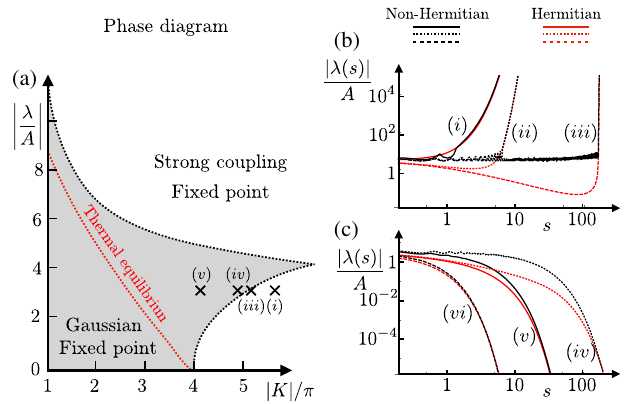
FIG. 2. (a) Phase diagram of the non-Hermitian sine-Gordon field theory, obtained from numerical integration of the flow equations (52) and (53). In the gray region the theory flows toward the Gaussian fixed point located at the origin. The phase boundary is signaled by the black dotted line. For comparison we also show the transition line for the Hermitian (thermal equilibrium) theory. Panels (b) and (c) display the renormaliza- tion group flow toward the strong coupling fixed point (b) and the Gaussian fixed point (c) for the non-Hermitian sine-Gordon theory and the corresponding Hermitian sine-Gordon theory (with comparably larger starting value of K ). The initial param- eters of the curves (i) and (iii)-(v) are displayed in (a); the remaining curves correspond to j K j ¼ 5 . 2 π for (ii) and j K j ¼ 3 π in (vi). All curves start at λ =A ¼ 3